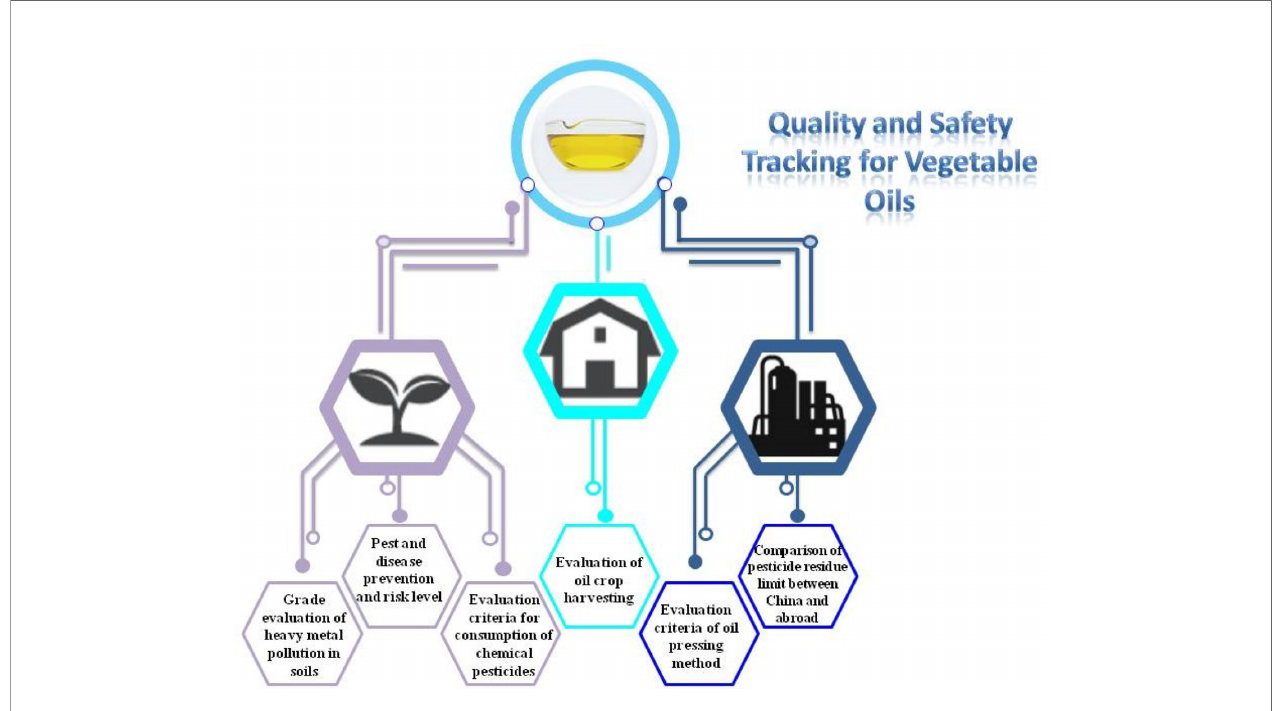
FIGURE 5 | The quality and safety of EPOs monitored during the whole industrial